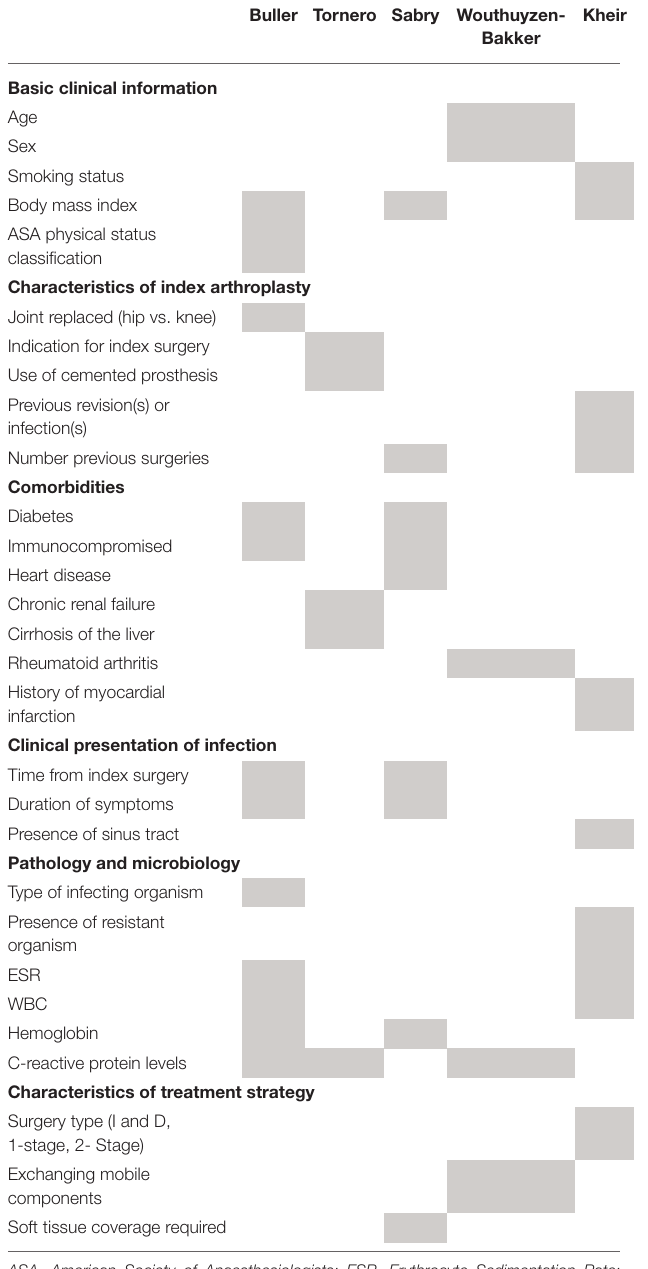
TABLE 2 | Predictors included in the five most widely cited tools to predict treatment outcomes of periprosthetic joint infection. Buller Tornero Sabry Wouthuyzen-